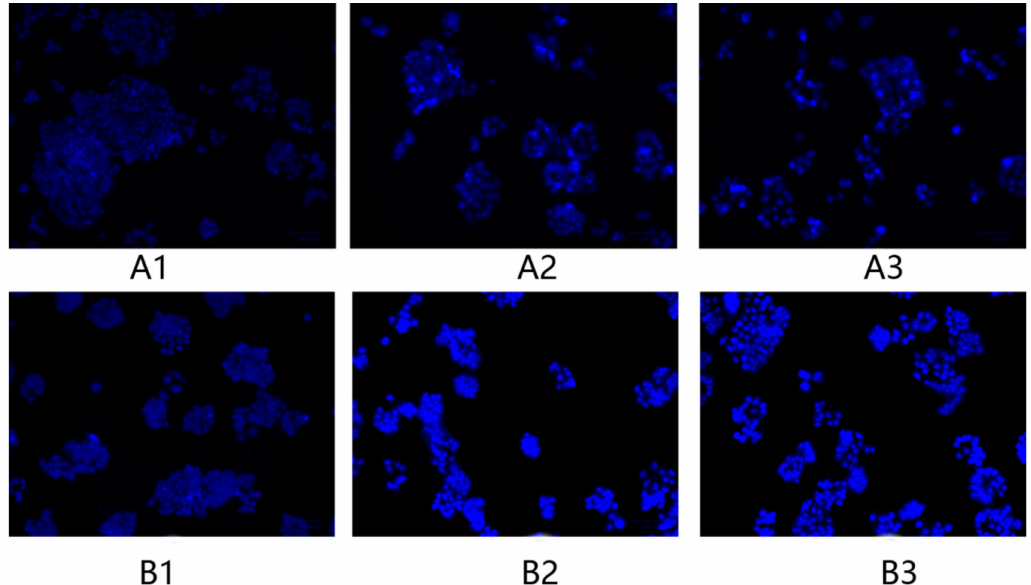
Figure 9. The morphology changes in HeLa cells in the ( A1 , B1 ) control group, ( A2 , B2 ) F1 treatment group, and ( A3 , B3 ) F3 treatment group after treatment for ( A ) 24 h and ( B ) 48